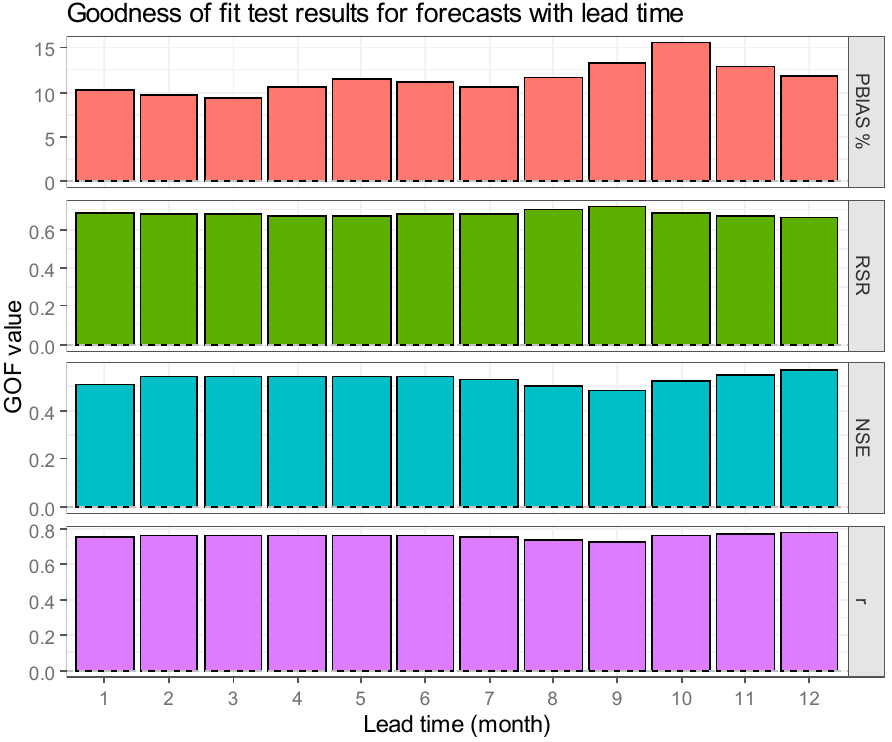
Figure 14. Results of the goodness-of-fit test for monthly precipitation forecasts.